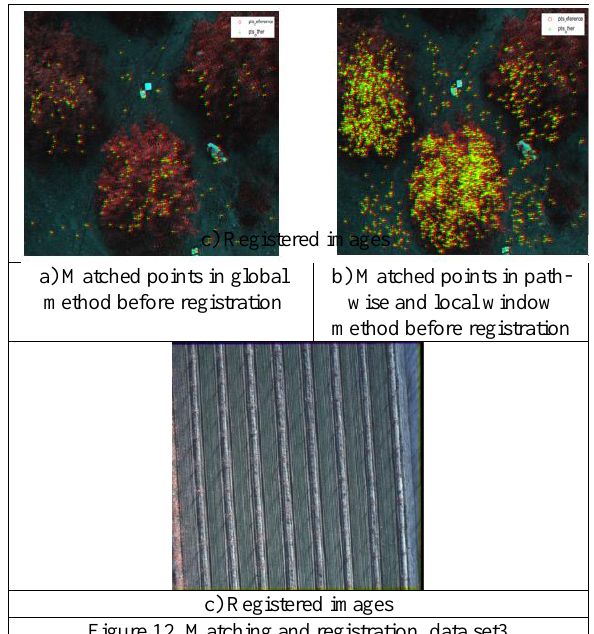
Figure 12. Matching and registration, data set3